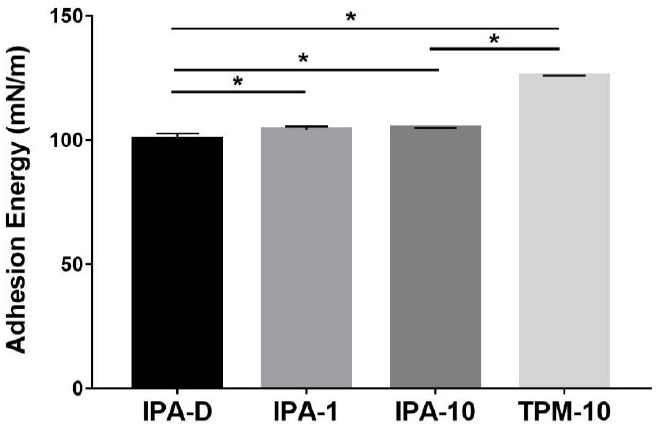
Figure 5. Adhesion energy according to different washing conditions: * significant difference at p < 0.05.